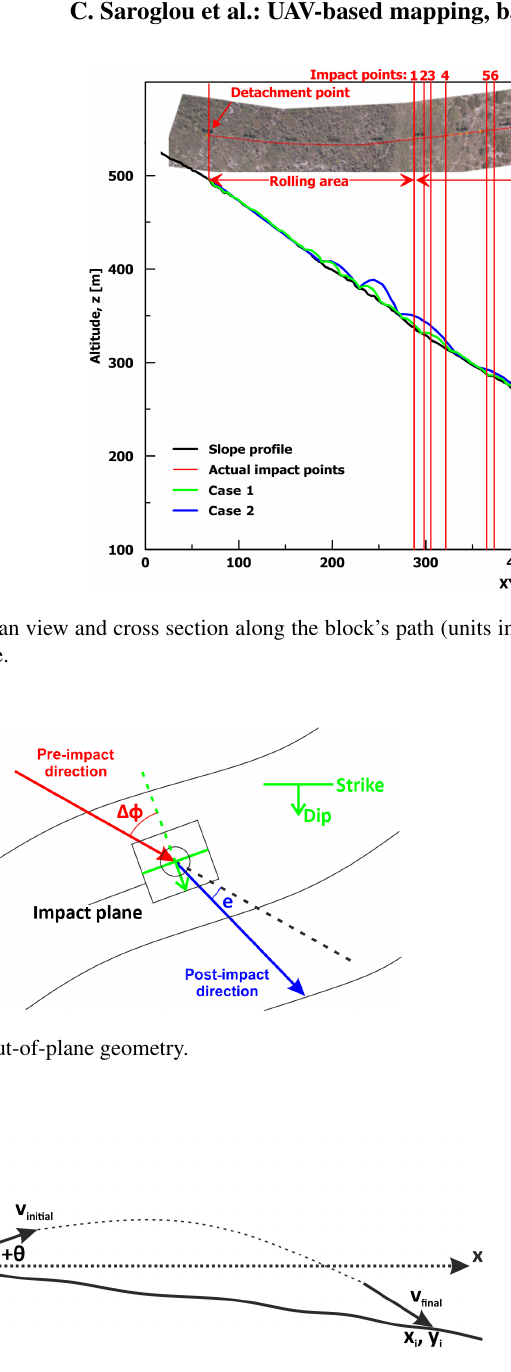
Figure 10. Parabolic segment.